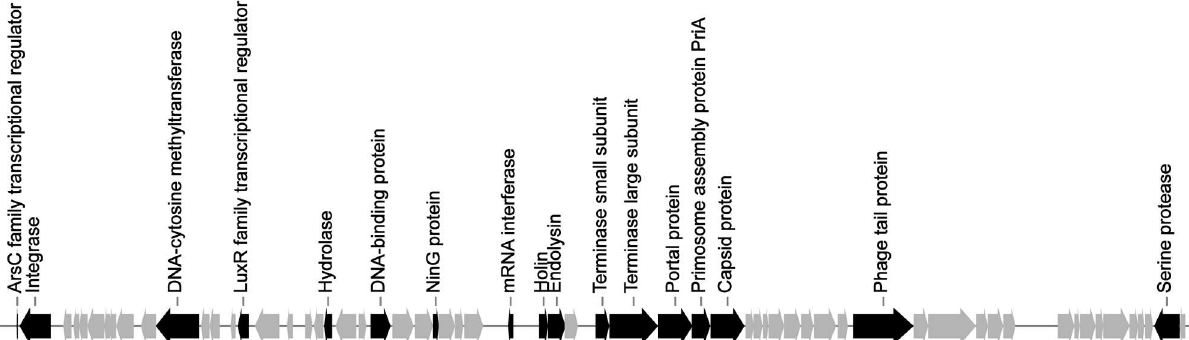
Fig 3. Genetic organization of prophage pp3. Genes are indicatedas arrows showingthe directionof transcription. Gray arrows represent genes encoding hypothetical proteins.